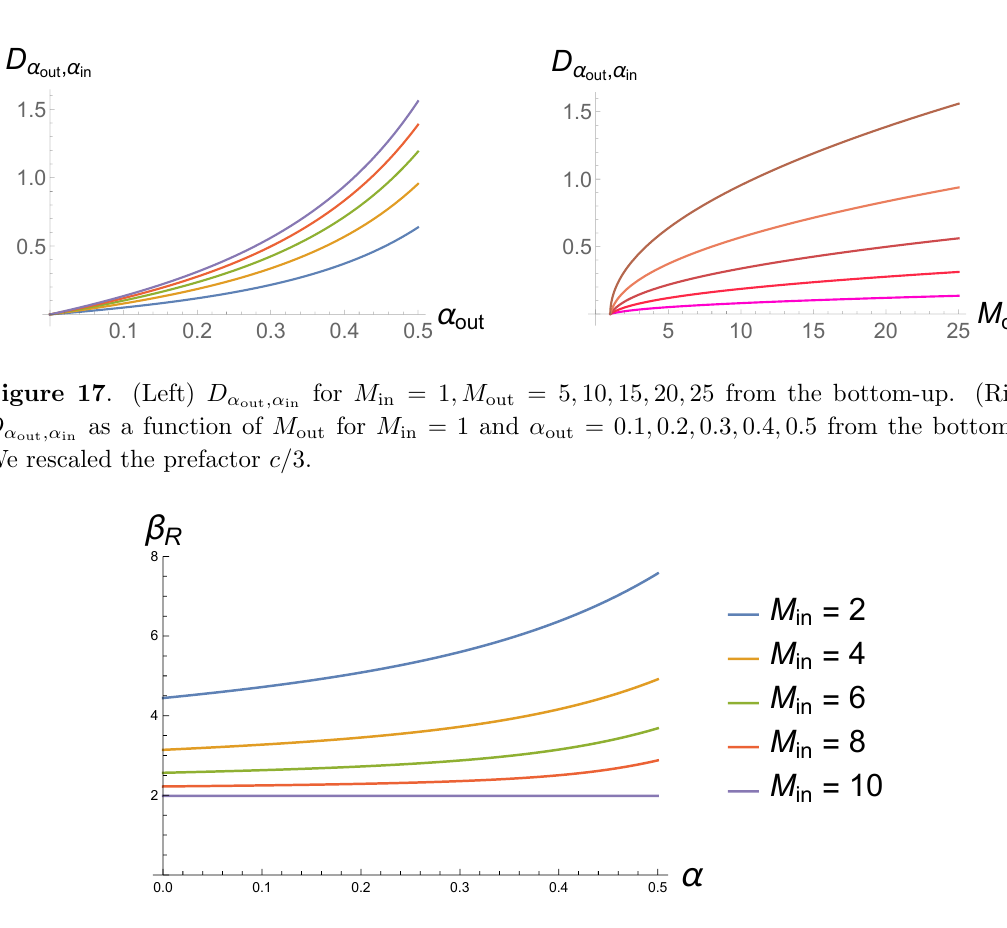
Figure 18 . Reference inverse temperatures (cid:12) R that can be accessed with this Euclidean geometric construction as a function of (cid:11) for M out = 10 and varying M in (cid:20) M out